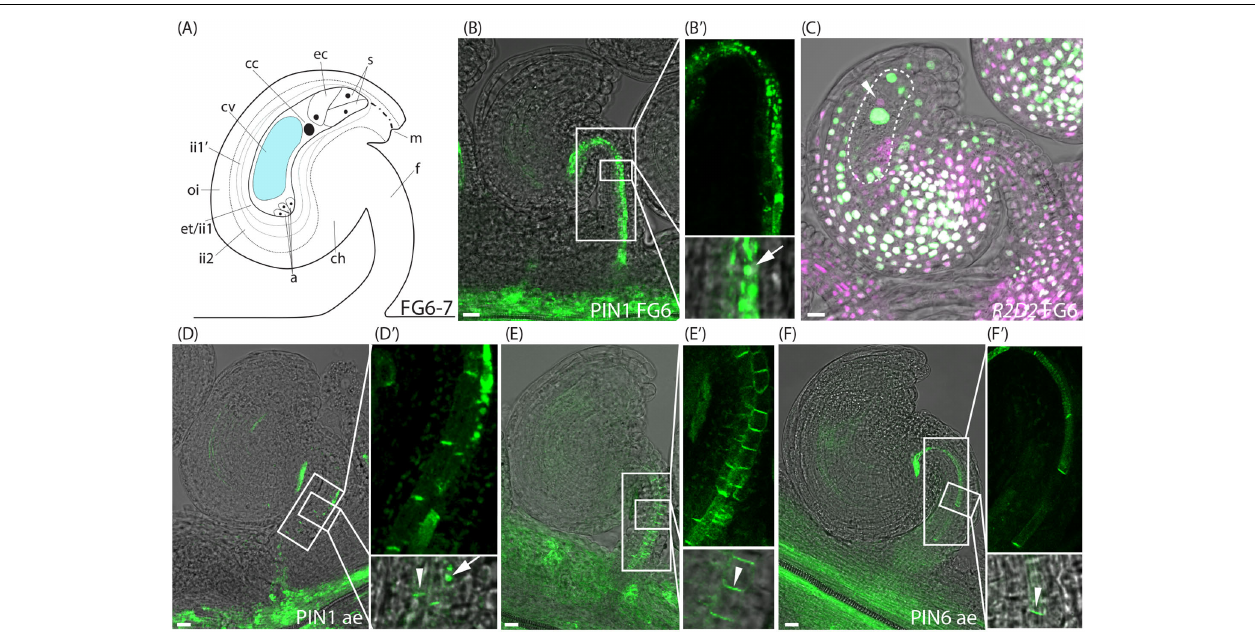
FIGURE 3 | Auxin sensing and transport in ovules at the pre-anthesis stage and after emasculation. (A) Schematic overview of an ovule at stage FG6-7. a, antipodal cells; cc, central cell; ch, chalazal domain; cv, central vacuole; ec, egg cell; et, endothelium; f, funiculus; ii, inner integuments; m, micropylar end; oi, outer integuments; s, synergid cells. (B,C) Merged confocal and transmitted light images of stage FG6 PIN1pro:PIN1-GFP (B,B (cid:48) ) and R2D2 (C) ovules just before anthesis. (B (cid:48) ) Shows higher magnifications of the boxed areas in (B) , arrow indicates internal PIN1 localization. Dotted area in (C) indicates the female gametophyte, arrowhead in (C) indicates DII depletion in the egg cell. (D–F) Merged confocal and transmitted light images of PIN1pro:PIN1-GFP (D,D (cid:48) ) , PIN3pro:PIN3-GFP (E,E (cid:48) ) , PIN6pro:PIN6-GFP (F,F (cid:48) ) ovules after emasculation. (D (cid:48) –F (cid:48) ) show higher magnifications of the boxed areas in (D–F) , respectively. Arrowheads indicate basal PIN1, PIN3, and PIN6 localization, respectively, arrow indicates internal PIN1 localization. Bars = 10 µ m. All images are representatives of at least 10 independent